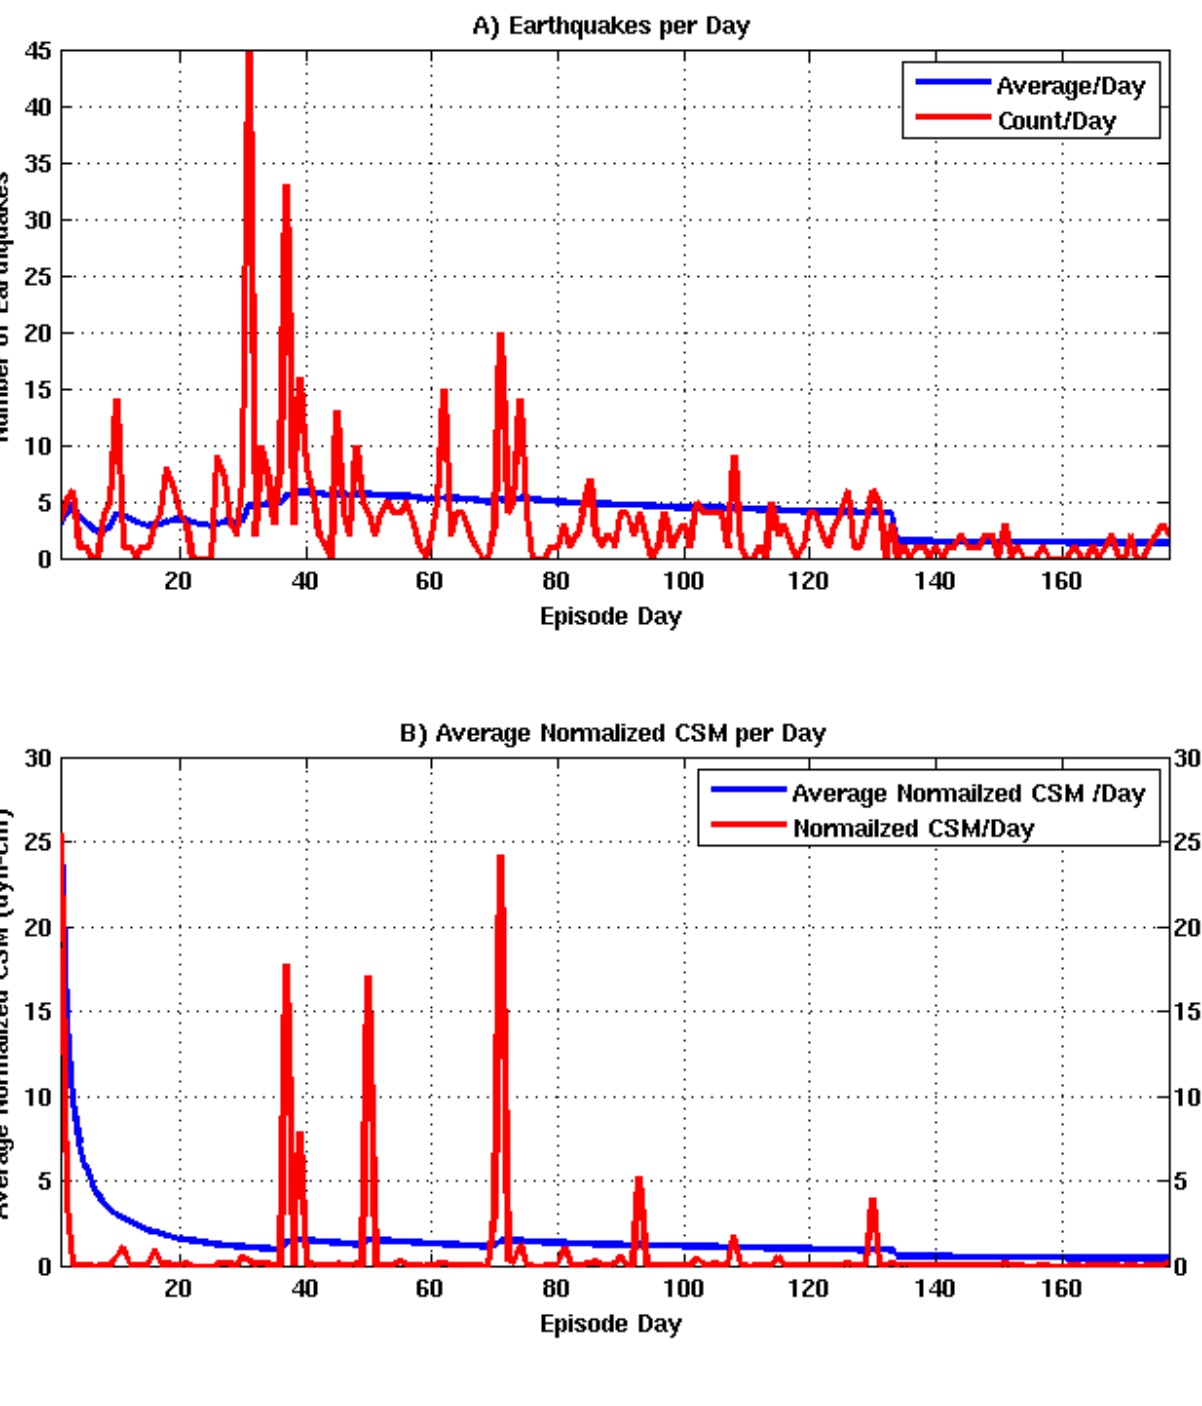
Figure 14. VEFA input parameters. ( A ) Count and average ( X ) number of earthquakes NE per episode day ( X ), shown in red and blue; ( B ) Raw and average ( X ) normalized DAY S CSM seismic moment per episode day ( X ), shown in red and DAY S